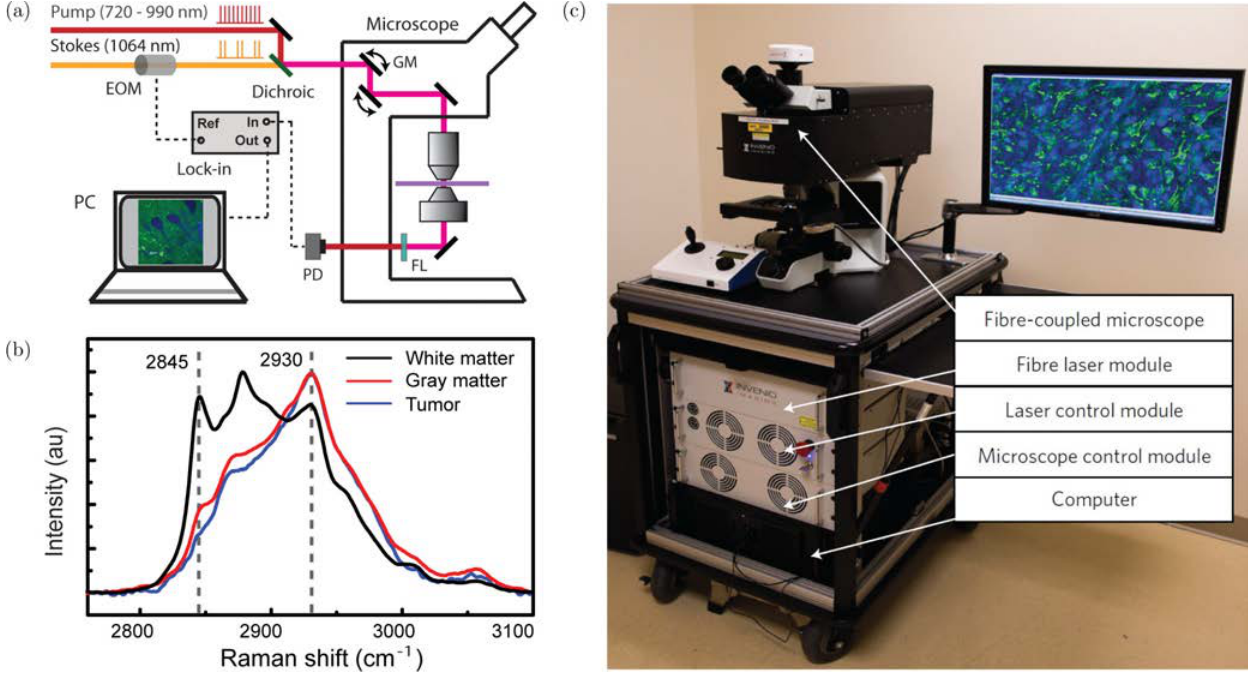
Fig. 2. Apparatus of SRS microscope: (a) Optical layouts of a typical SRS microscope, (b) Raman spectra of brain tissues in the regions of white matter, gray matter and tumor and (c) ¯ber laser-based SRS microscope that could be used in the operating room. EOM: electro-optical modulator, DM: dichroic mirror, PD: photodiode, GM: galvo mirrors, FL: optical